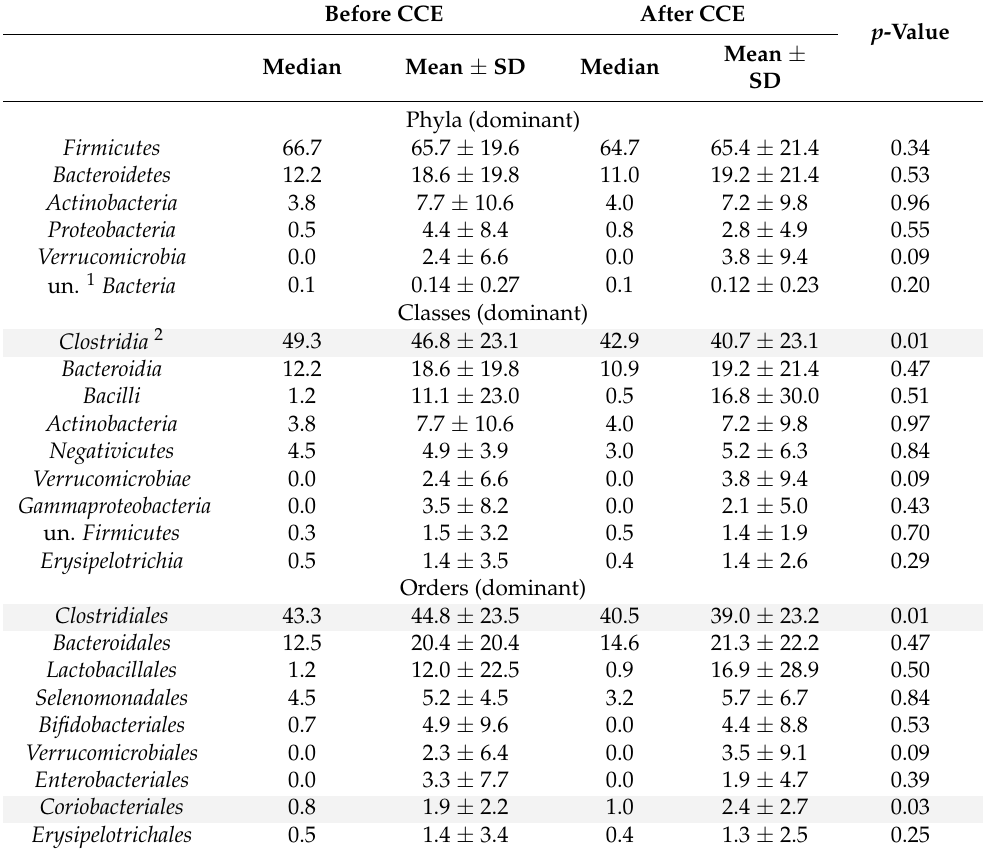
Table 5. The relative abundance of some higher bacterial taxa in patients’ feces before and after CCE. Before CCE After